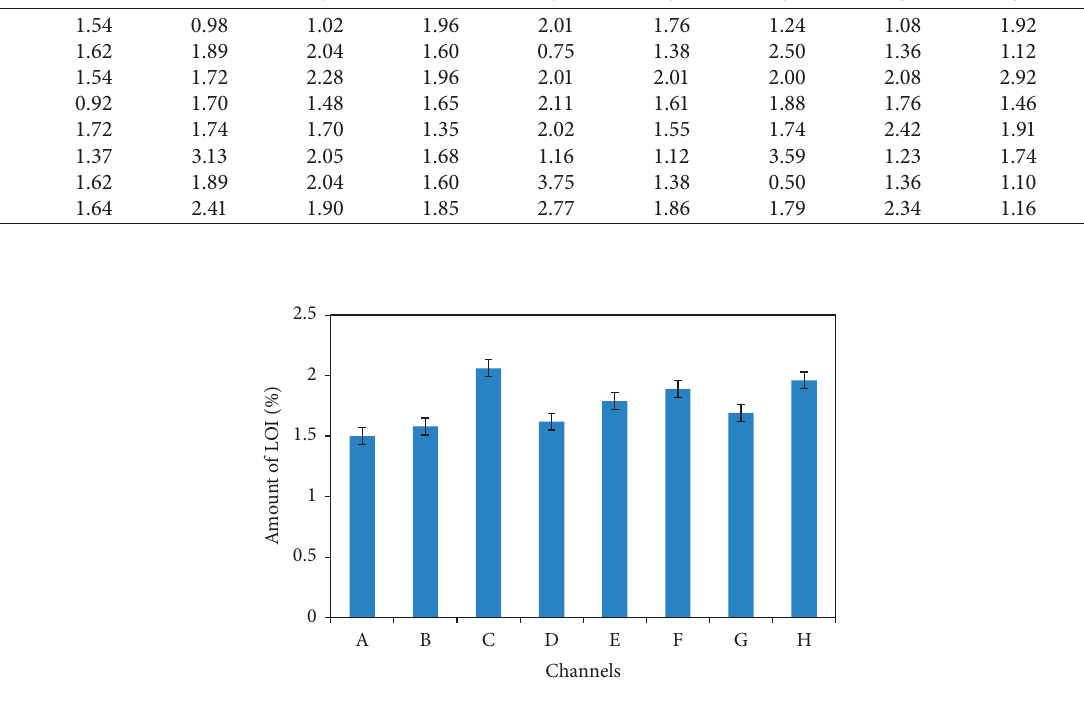
Figure 2: Average percentage of LOI in hematite ore of Pokhari. The presented values are the average of nine samples for each channel ranged from A to H. Table 2: Acid insoluble material values of different samples of hematite ore (in percentage). The mean value in the table represents the mean of nine samples for each channel assigned from A to